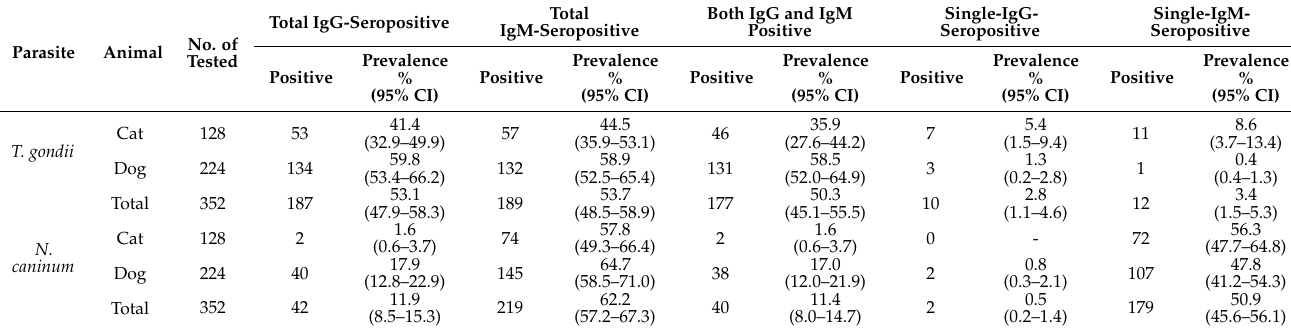
Figure 2. Cross-reaction analysis between the recombinant proteins of T. gondii and N. caninum and another parasitic antibody. ( A ) Results of the interaction of the recombinant proteins of T. gondii and N. caninum with T. gondii -positive sera of stray dogs and cats, respectively. ( B ) Results of the interaction of the recombinant proteins of T. gondii and N. caninum with N. caninum -positive sera of stray dogs and cats, respectively. Table 1. Seroprevalence of T. gondii- and N. caninum -specific IgG and IgM among stray cats and dogs in the QTPA, China.